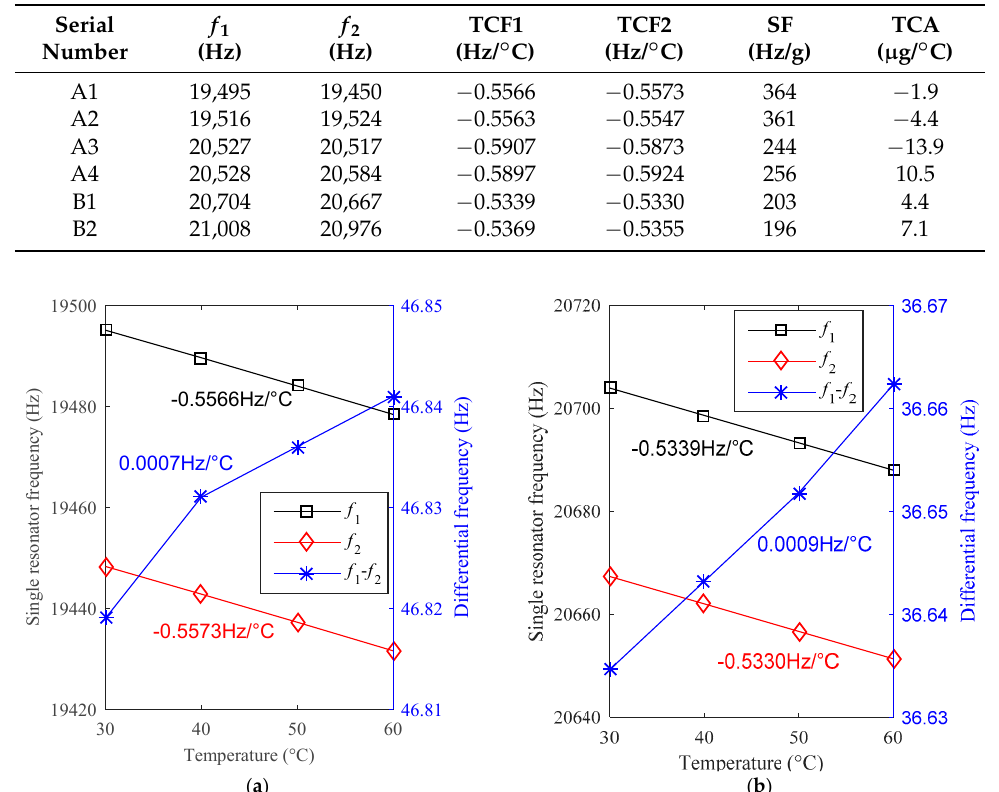
Figure 11. The measured temperature drifts of two MRA prototypes: ( a ) prototype A1 designed by method A, ( b ) prototype B1 designed by method B.